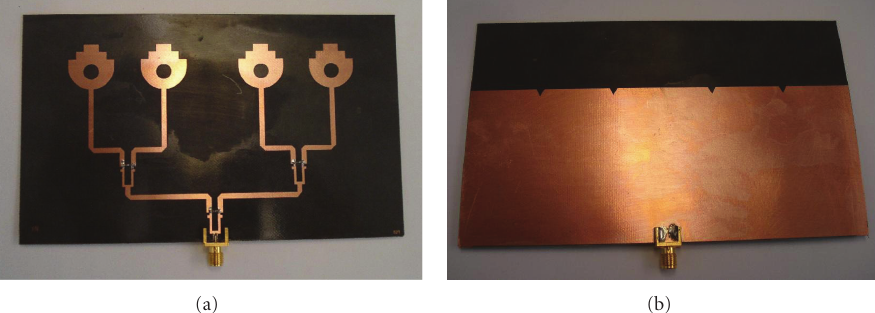
Figure 21: Fabricated four-element UWB linear antenna array with corporate feed ( T -junction power divider), (a) top view and (b) bottom